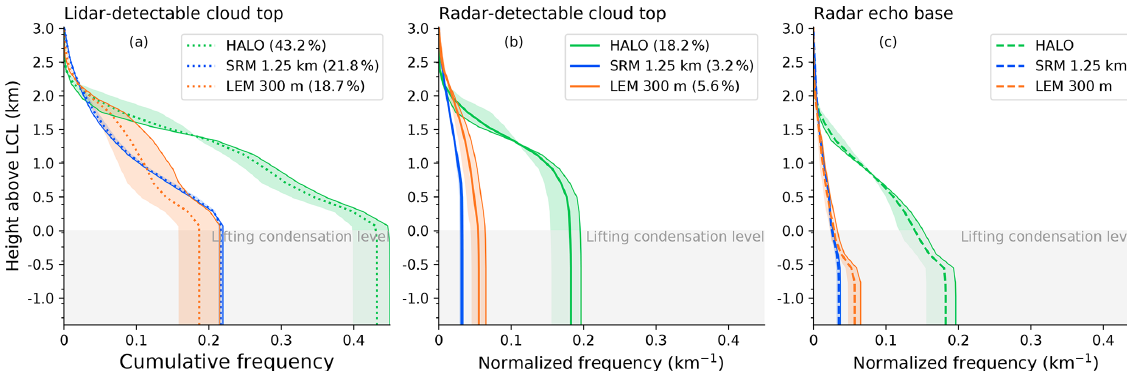
Figure C1. Cumulative cloud cover statistics on all observed and forward-simulated lidar and radar signals: (a) lidar cloud top, (b) radar cloud top, and (c) radar echo base. Same thresholds for cloud detection are used for the observed and simulated lidar and radar signals. Height is in relation to the lifting condensation level (LCL). Shadings depict western (bright edge) and eastern (dark edge) half of each dataset. The histogram bin edges are depicted as ticks on y axis. Total shallow 2D cloud coverage (i.e., the x axis intercept) detected by lidar and radar in each dataset are given in the legends. This figure is the cumulative version of Fig. 5.